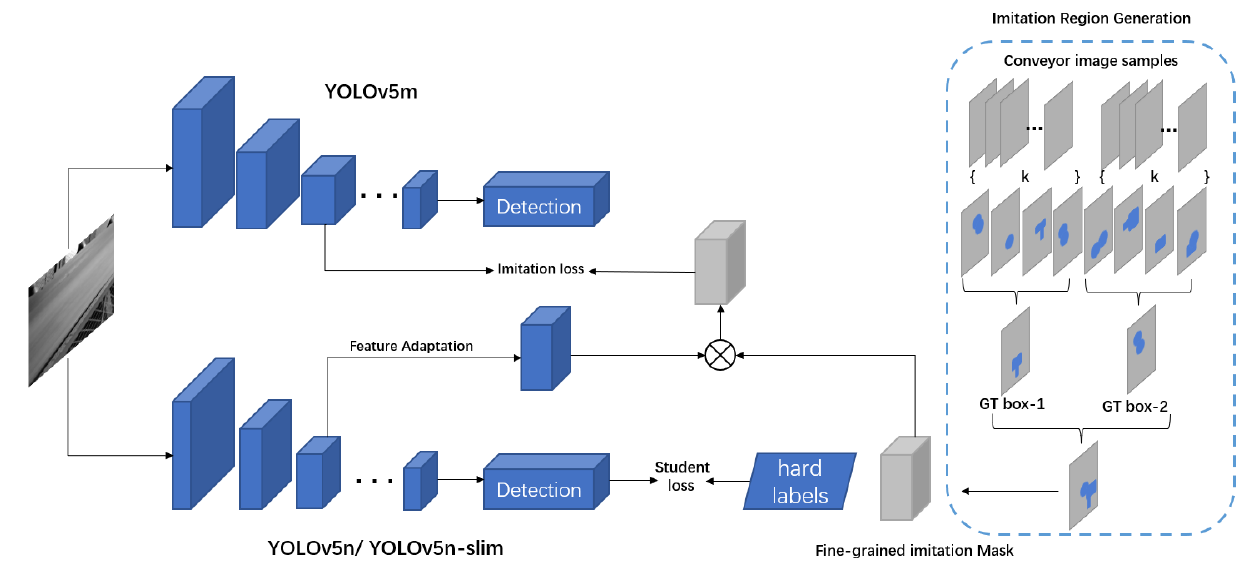
Figure 8. Structure of knowledge distillation network based on YOLOv5.